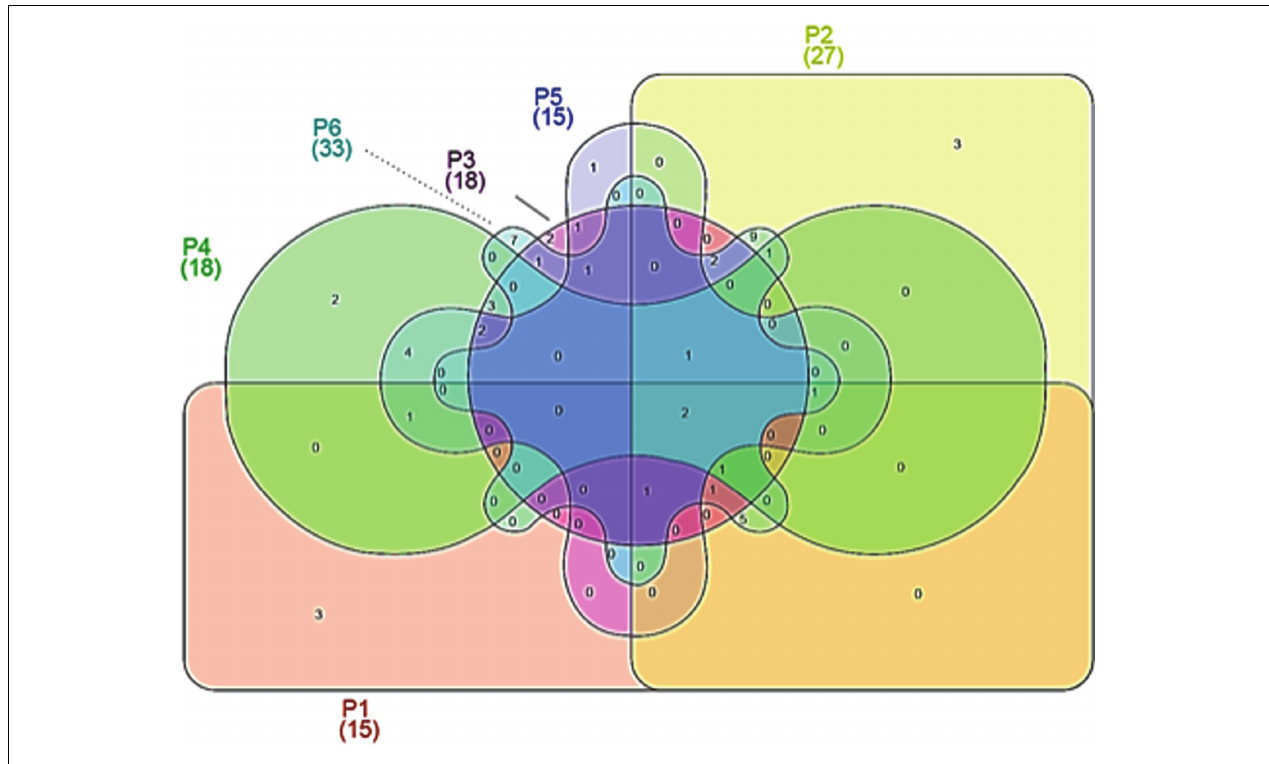
FIGURE 2 | Venn diagrams showing operational taxonomic units (OTUs) at species level, depicting similarities and differences among in the microbial community in six Masa agria samples from different producers (P,